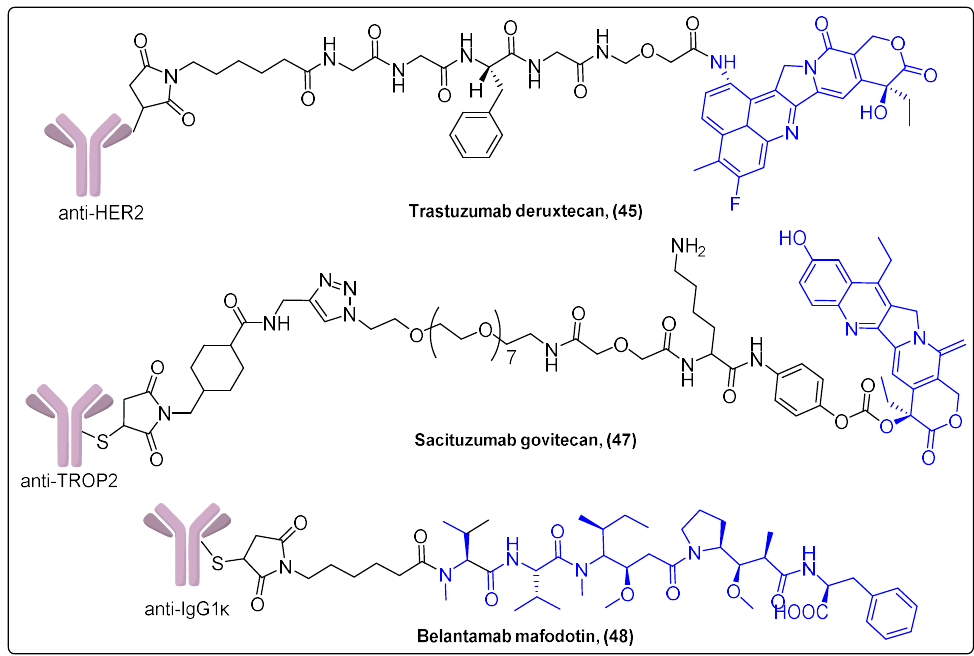
Figure 14. Antibody–drug conjugates carrying exatecan, SN-38 or MMAF.